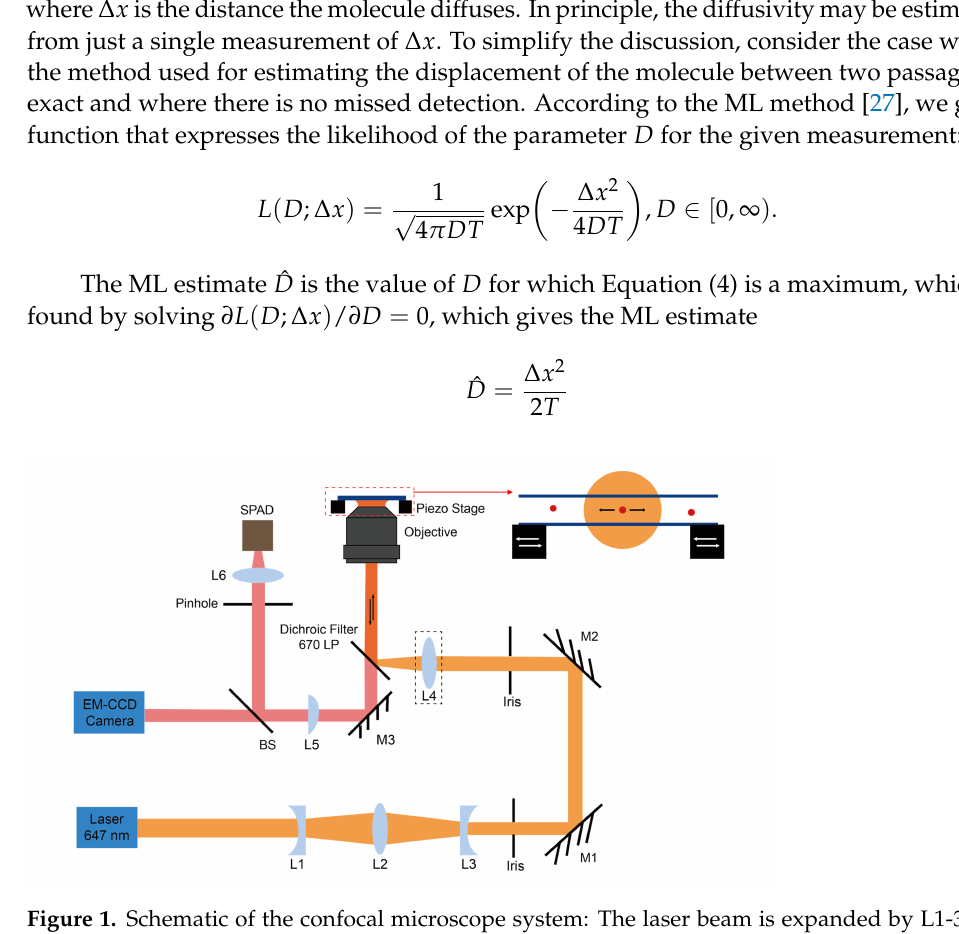
Figure 1. Schematic of the confocal microscope system: The laser beam is expanded by L1-3 (L1, 150 mm focal length, plano-concave lens; L2, 100 mm focal length, bi-convex lens; L3, 75 mm focal length, plano-concave lens) to fit the entrance pupil of the objective and passes through an Iris and is then raised by mirrors M1-2 to the level of the dichroic filter. L4 (150 mm focal length , biconvex lens) is a removable Kohler lens placed at the back focal point of the objective to achieve Kohler illumination. The laser beam is reflected by the dichroic filter to the objective, the collected fluorescence passes through the dichroic filter and is focused with L5 (250 mm focal length, plano- convex lens). The beam is then split by beam sampler (BS) to an EM-CCD camera and through a pinhole to focus on an sing-photon avalanche diode (SPAD). The inset highlights the piezo stage and the microchannel device, where the molecule diffuses through the focal volume and the microchannel is moved back and force by the piezo stage. The capillary is translated to one end of the recycle and is moved back after a fix reversal delay reduced by the translation time. Therefore, the molecule is moved through the focal volume after each reversal delay. The combined movement of the molecule resembles that of SMR in a nanochannel, where the molecule is driven by the